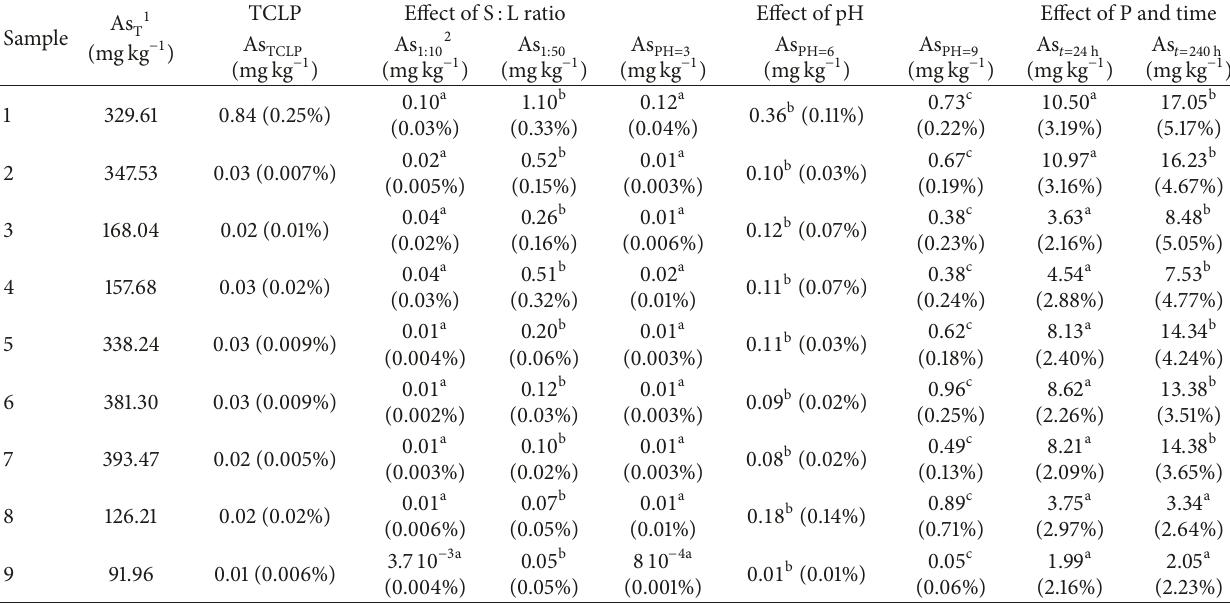
Table 2: As leachability in TCLP and the effect of pH, solid: liquid ratio, phosphorous, and time on As mobilization. Sample